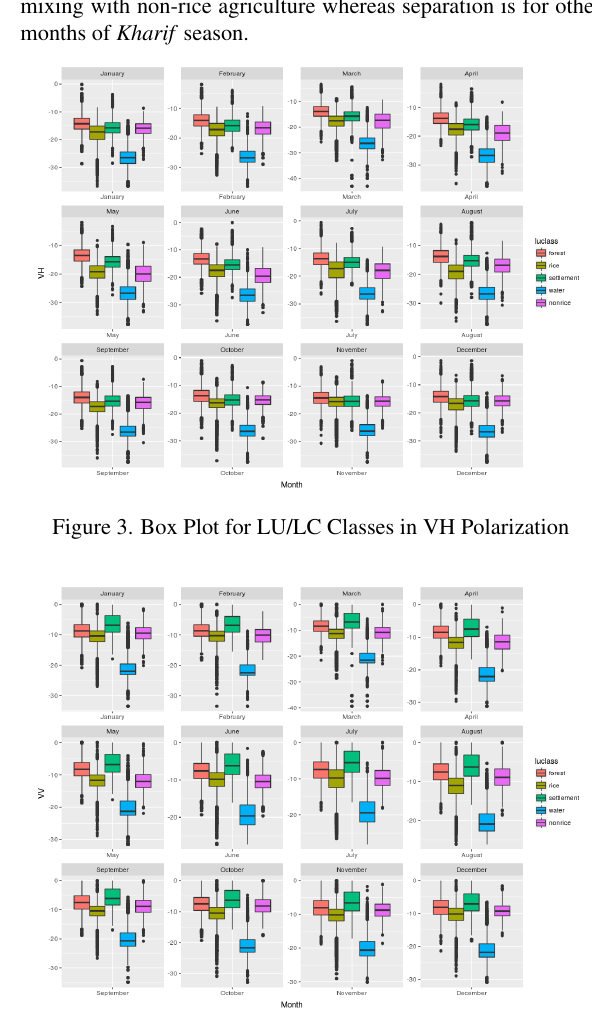
Figure 4. Box Plot for LU/LC Classes in VV